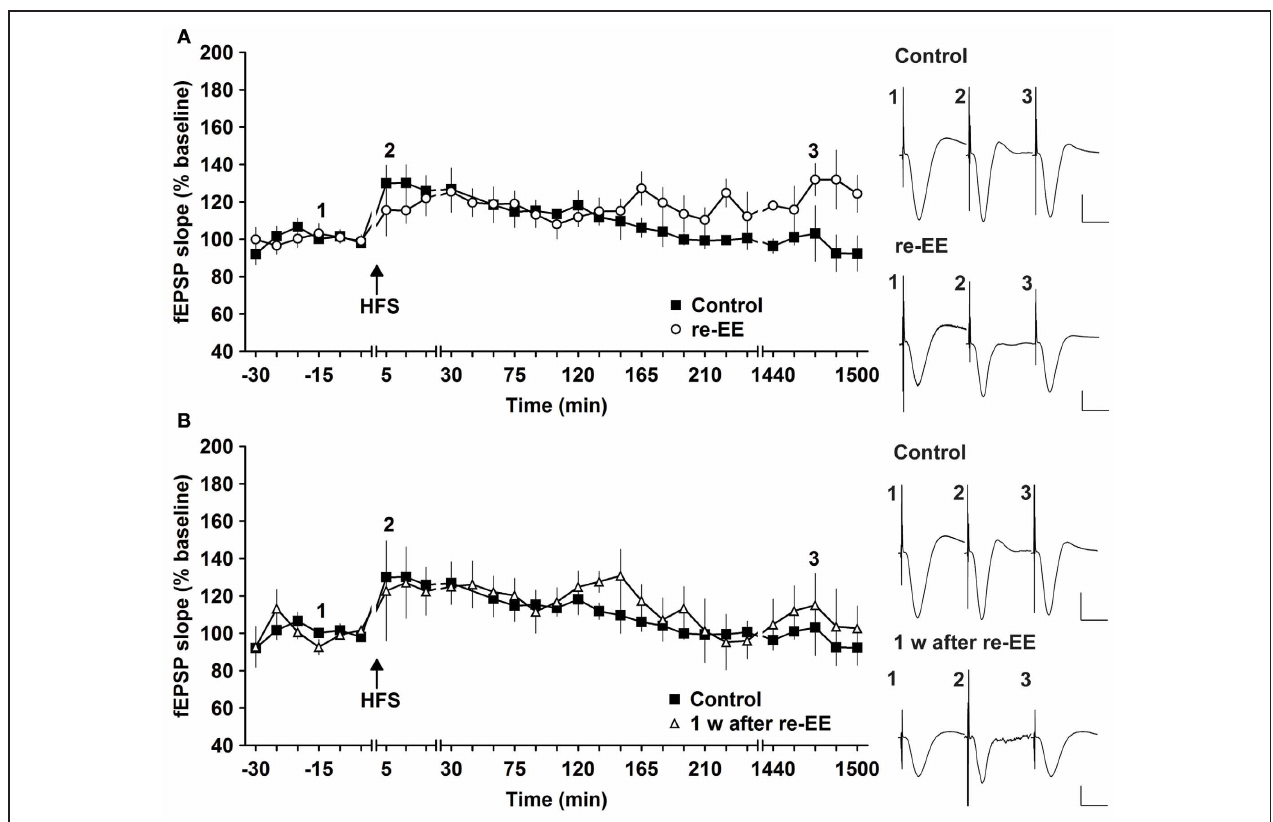
FIGURE 2 | Early-long-term potentiation is facilitated into late-long-term potentiation by re-exposure to environmental enrichment. Six weeks after cessation of environmental enrichment (EE), animals were once more exposed to EE for 14 days. (A) In this case, E-LTP was prolonged into L-LTP that lasted for over 24h. (B) Seven days after